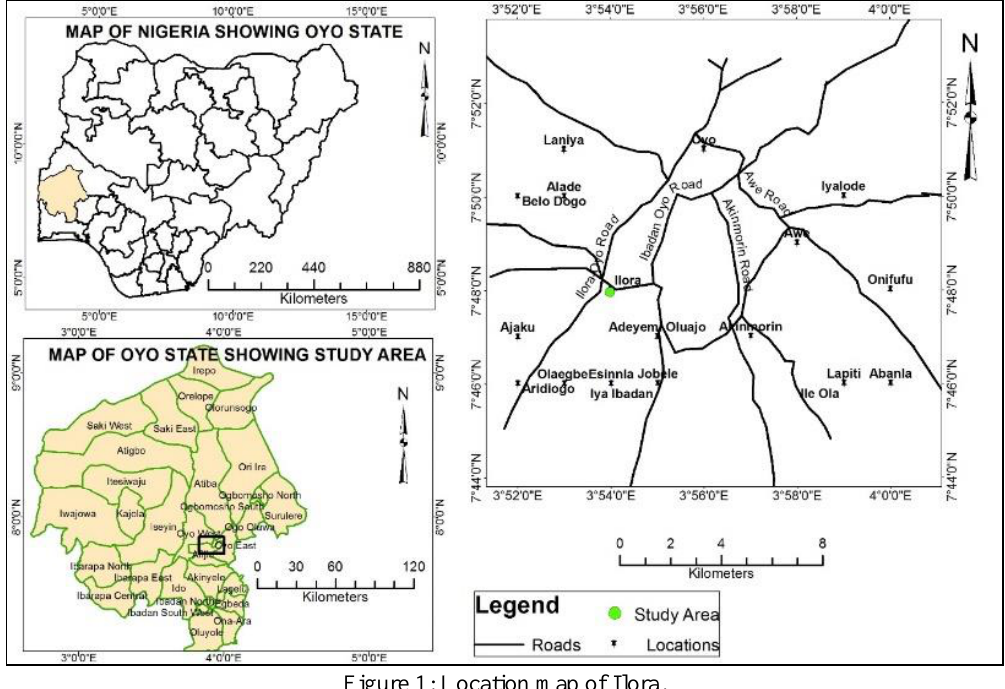
Figure 1: Location map of Ilora.